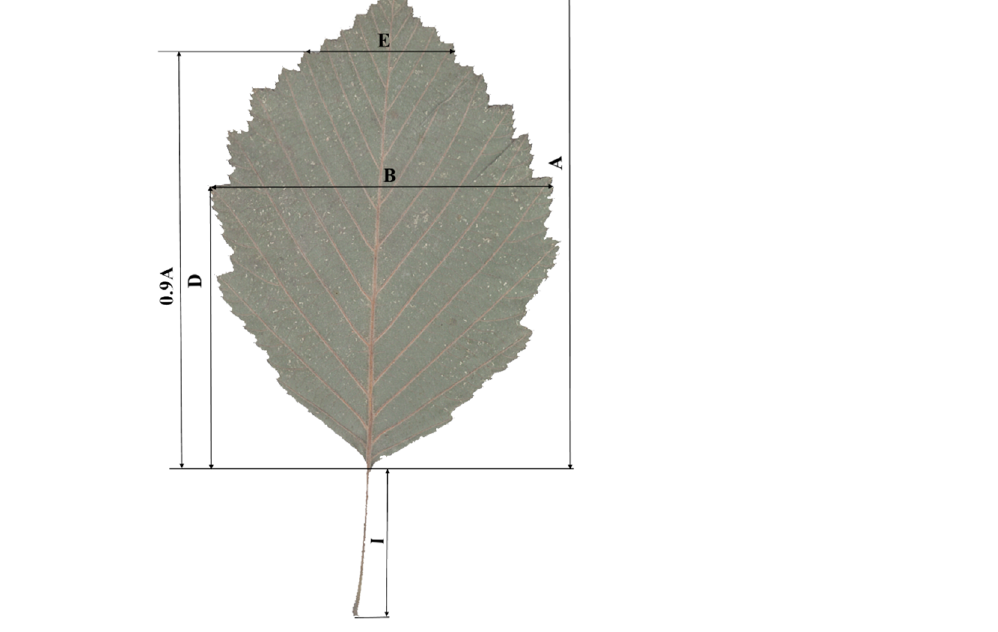
Figure 2. Morphological traits of leaves (by [28]). A—blade length, mm; B—blade maximum width, mm; D—length to position where maximum blade, mm; I—petiole length, mm; E—blade width measured at 90% blade length, mm; W—upper angle of leaf, degrees.